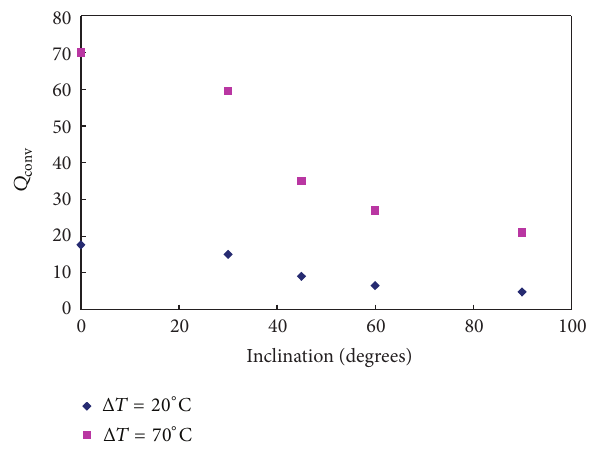
Figure 5: Variation of the convective loss (in Watts) with Δ𝑇 and inclination for open cubical cavity of side 0.5m.